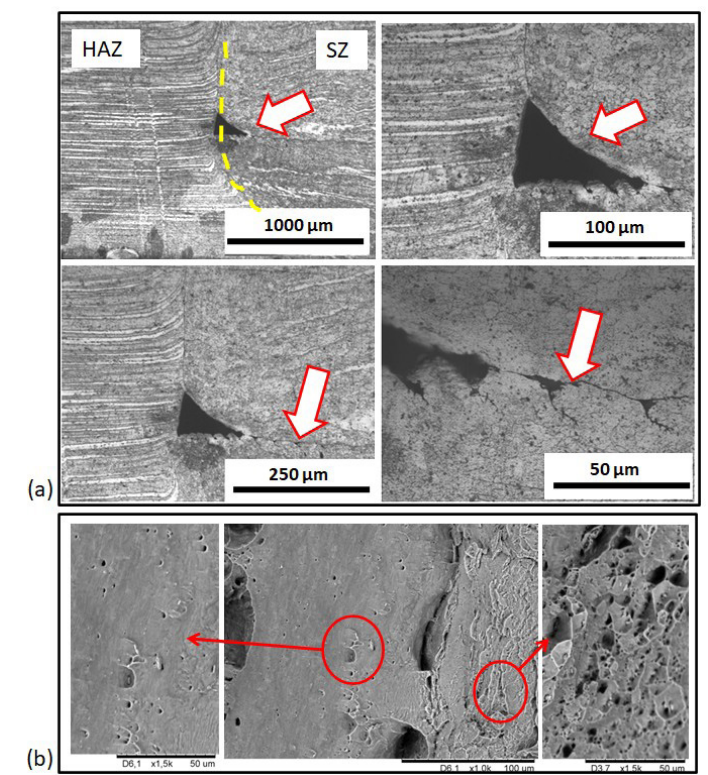
Figure 5. (a) Microstructural detail and defect formation and (b) fractography obtained after tensile testing of the sample with 2,000 rpm rotational speed.